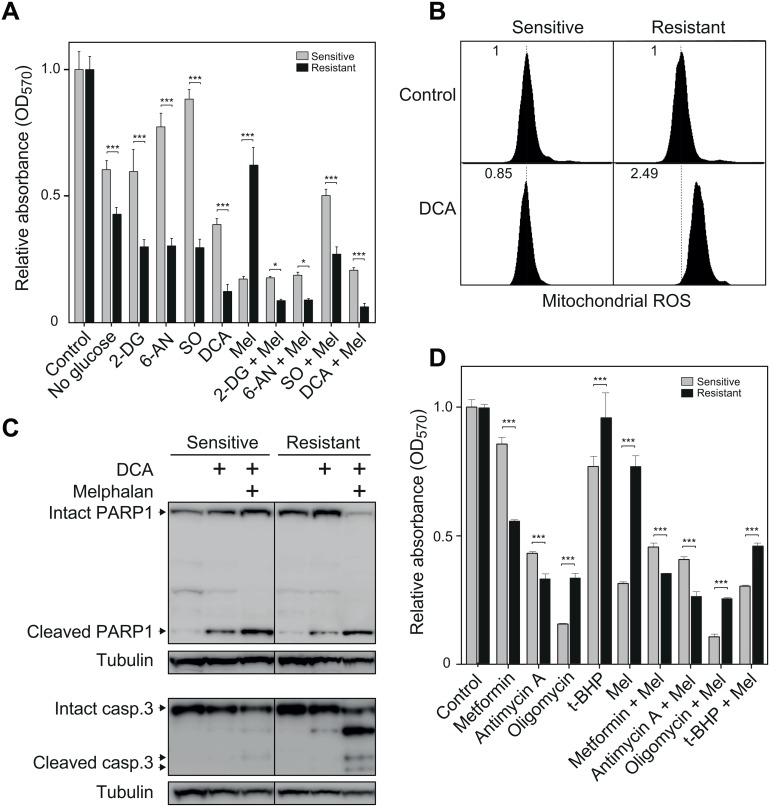
Melphalan-resistant cells are selectively sensitive to inhibitors targeting enzymes in glycolytic- and pentose phosphate pathways as well as complexes in the mitochondrial electron transport chain.(A), Bar diagram illustrating effect of inhibitors targeting various enzymes in carbohydrate metabolism (2-DG, 1 mM, 6-AN, 1 mM, SO, 20 mM, DCA, 10 mM) when administered in the presence or absence of 2.5 μM melphalan (Mel). (B), DCA treatment selectively mediates increased mitochondrial ROS in the resistant cells. (C), Western analysis of the apoptotic markers PARP1 (upper panels) and caspase-3 (bottom panels) illustrating increased cleavage of both proteins subsequent to co-treatment of the resistant cells with DCA and melphalan. (D), Bar diagram illustrating effect of inhibitors targeting the mitochondrial electron transport chain or ATP synthesis (metformin, 3 mM, antimycin A, 30 μM, oligomycin, 10 μM) and the general pro-oxidant tBHP (20 μM) when administered in the presence or absence of 2.5 μM melphalan. (E), Western analysis of AKT1 and pAKT1 in the sensitive and resistant cells.